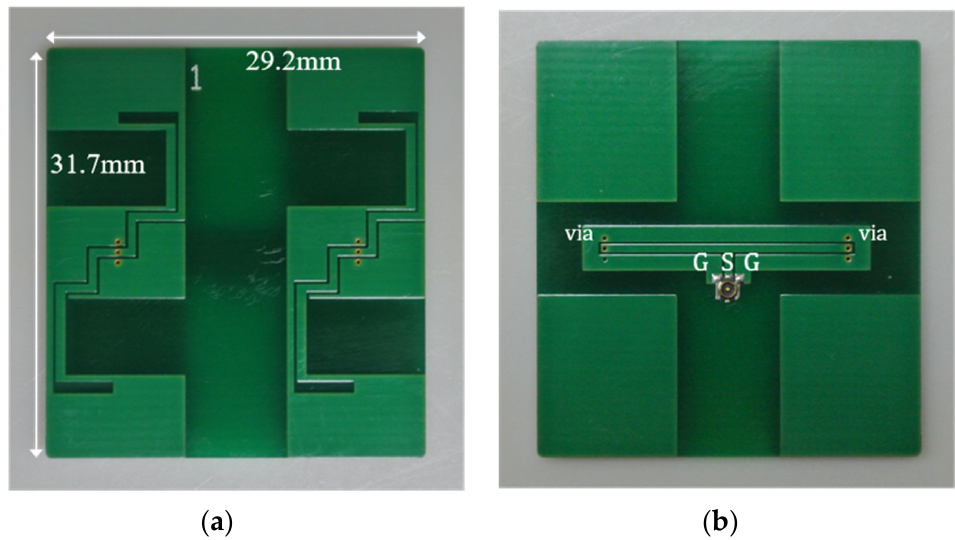
Figure 10. Photograph of the 2 × 2 array antenna board: ( a ) front structure and ( b ) back structure.